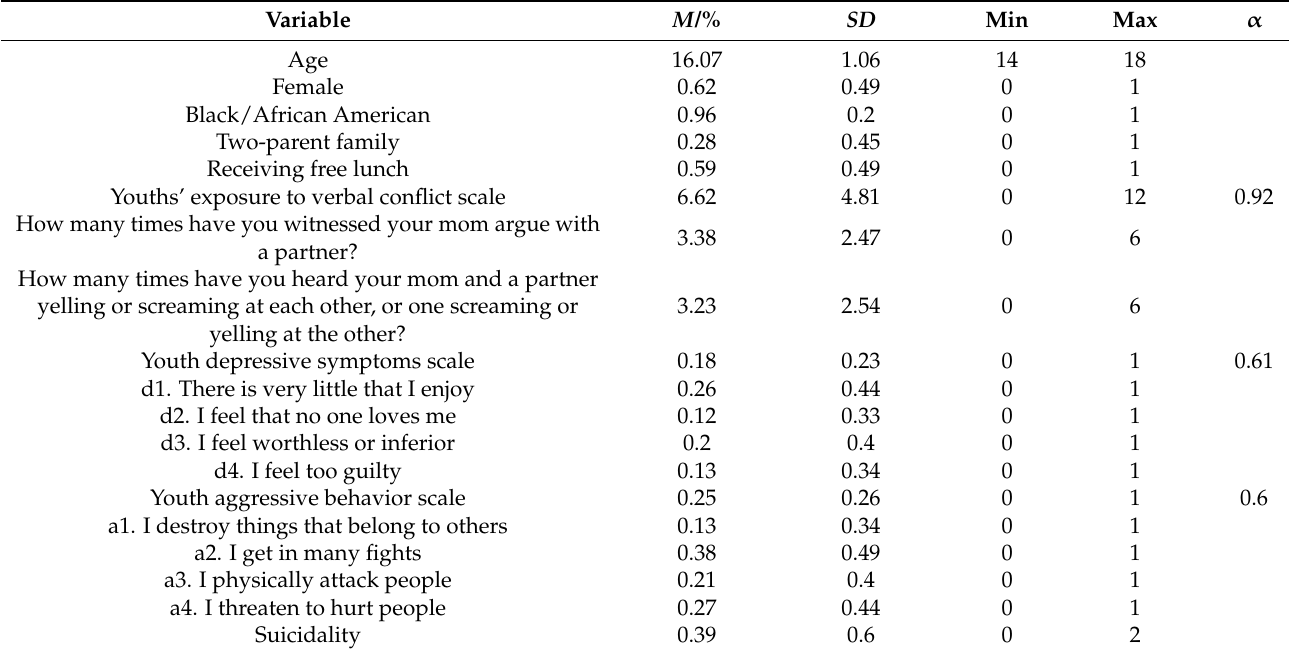
Table 1. Descriptive statistics of the study sample ( n =